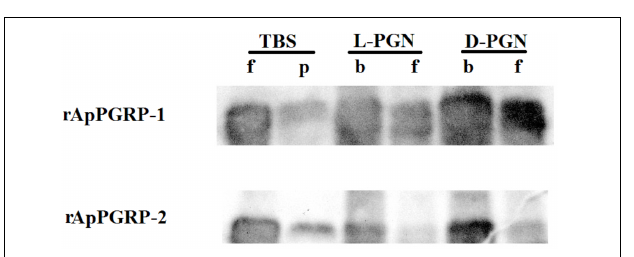
FIGURE 6 | rApPGRP-1 and -2 bind Lys-type PGN from S. aureus and Dap-type PGN from B. subtilis . f, free; p, pellet; b,